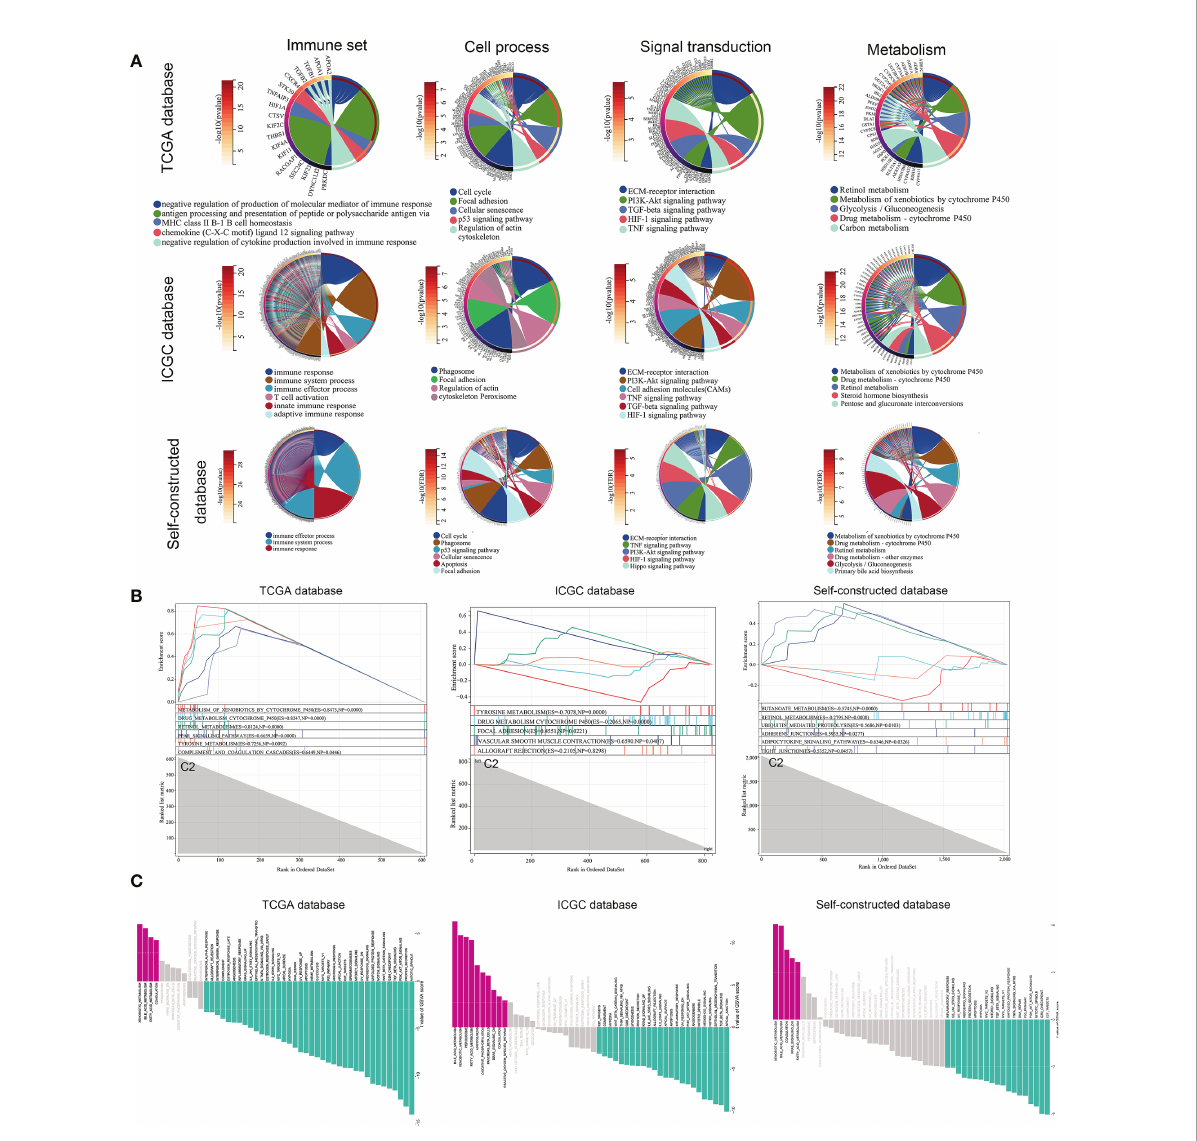
FIGURE 4 Gene differences and pathway enrichment between C1 subtypes and C2 subtypes. (A) Enrichment analysis of immune, metabolic, signaling pathways and cellular processes based on TCGA, ICGC and Self-constructed database. (B, C) Enrichment analysis of GSEA and GSVA based on TCGA, ICGC and Self-constructed